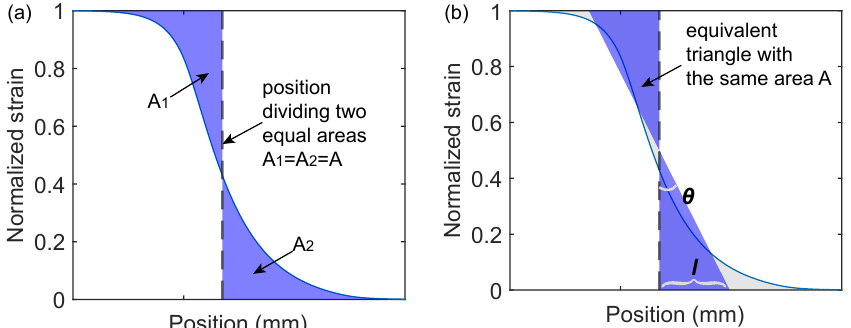
Figure 18. Parameters l and θ indicating smoothing effect of the coating layer: ( a ) Illustrative strain distribution; ( b ) equivalent strain distribution and physical meaning of l and θ